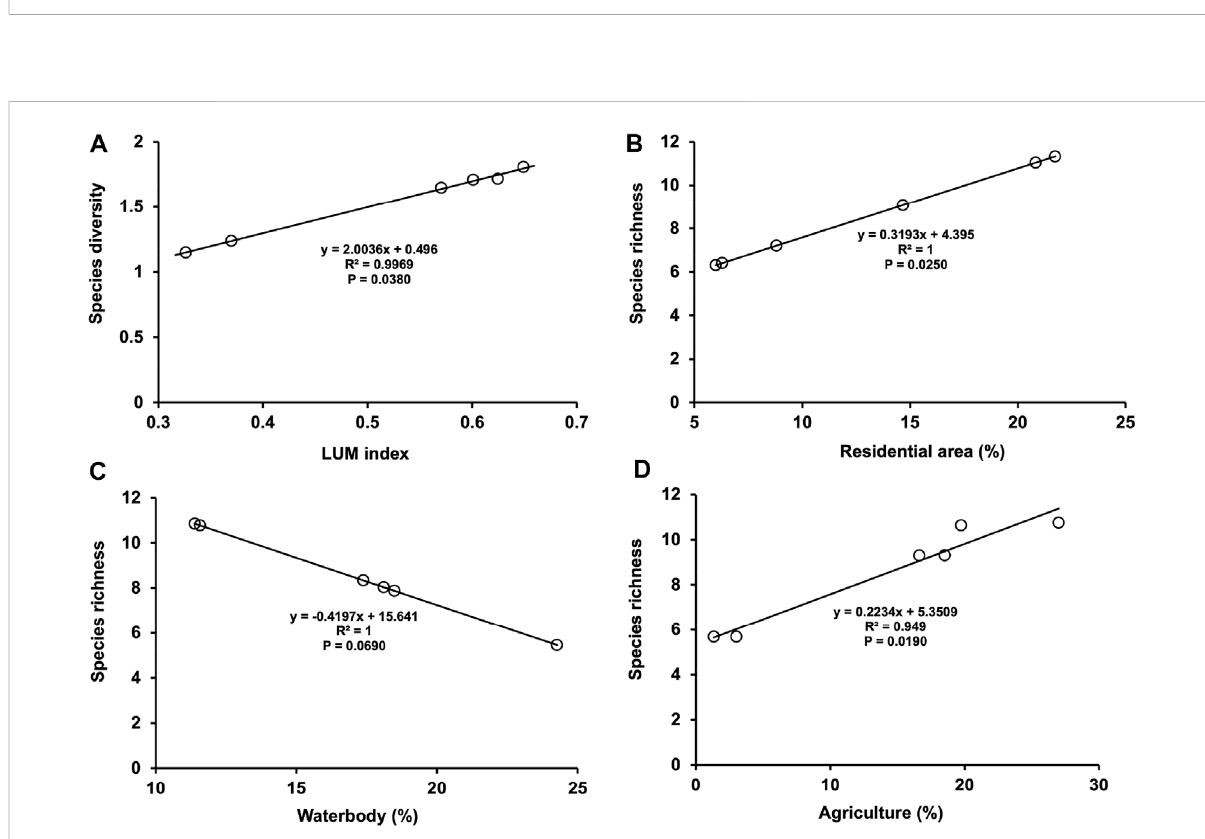
FIGURE 6 Model estimated species diversity (predicted Shanon index) and predicted species richness against different landscape variables and land use mix (LUM)